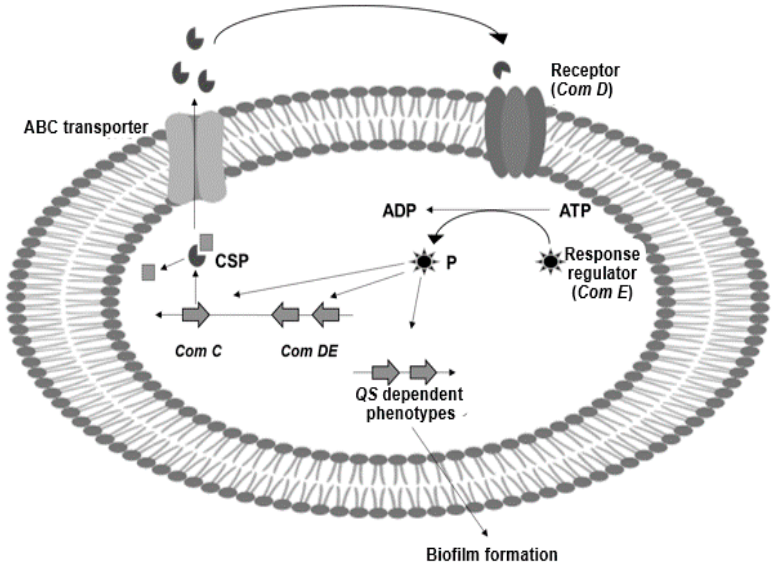
Figure 1. The intercellular communication system of S. mutans . Planktonic cells initiate intercellular communication through the excretion of a stimulating peptide (CSP), which is recognized and activates the signaling cascade to express genes involved in biofilm formation.